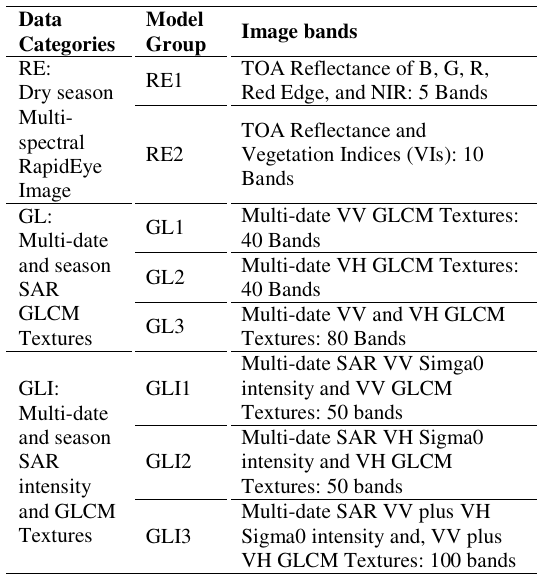
Table 3: The respective image stacks, used to compare the Random Forest (RF) classification